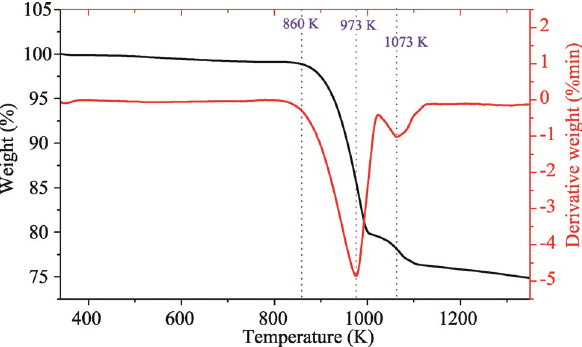
Fig. 2 TGA of Ca 3 Co 4 O 9 powder.